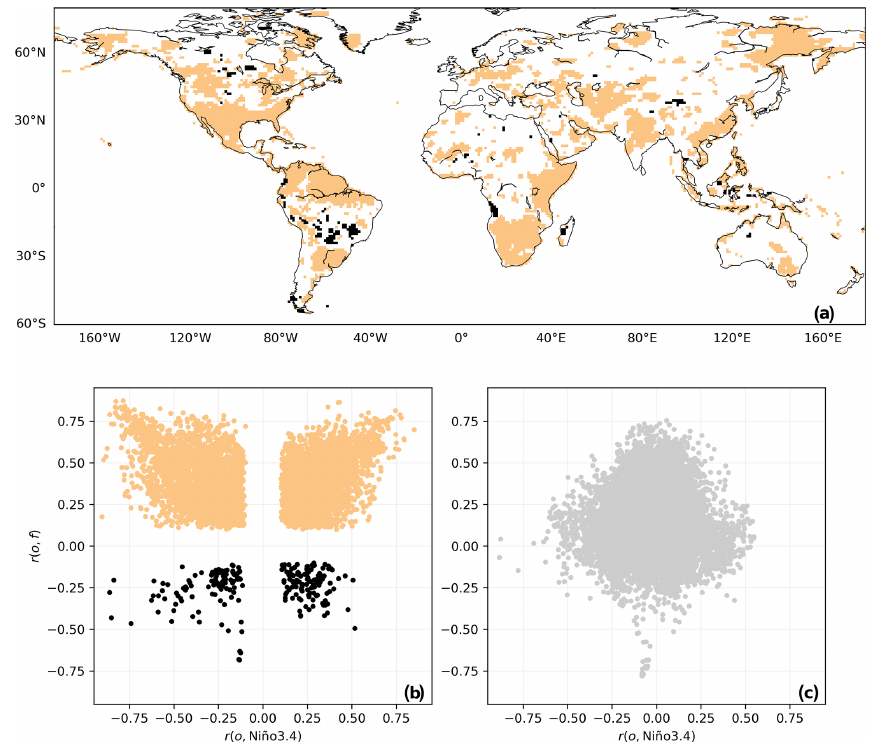
Figure 5. (a) Spatial distribution of grid cells with significant overlapping R 2 for CFSv2 forecasts generated in December and Niño3.4 in DJF. Scatter plots of anomaly correlation against ENSO teleconnection for grid cells (b) with significant overlapping R 2 and (c) with non-significant overlapping R 2 . Grey points in panel (c) are marked in white in panel (a)